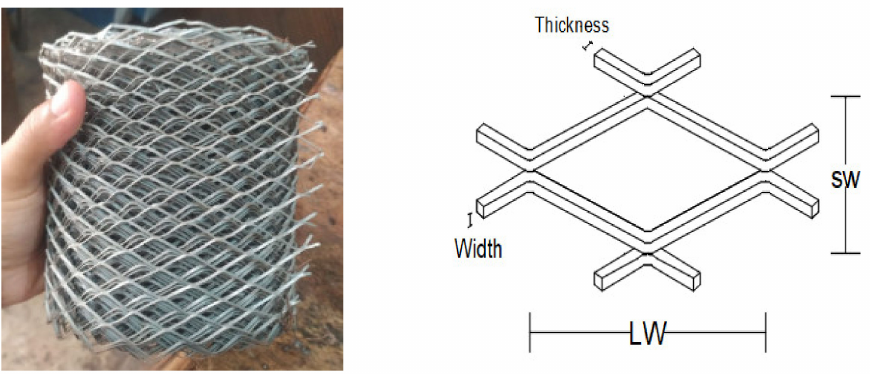
Figure 11. Average stress–strain curves for stainless steel strips.